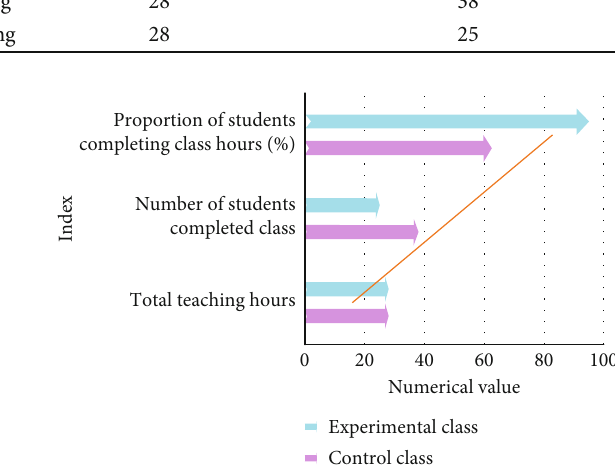
Figure 1: Analysis of class completion of two classes.